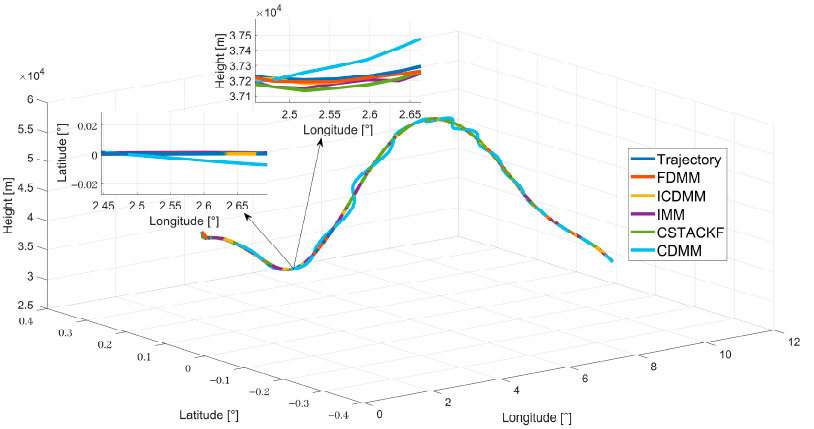
Figure 13. The average CPU time per period for different algorithms in Case 2.